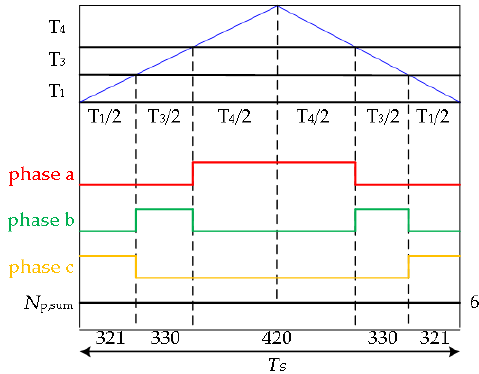
Figure 8. The sector division of 0CMV-SVPWM.